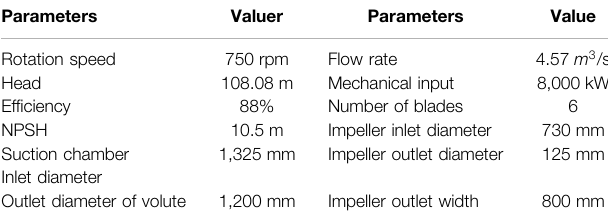
TABLE 2 | Centrifugal pump